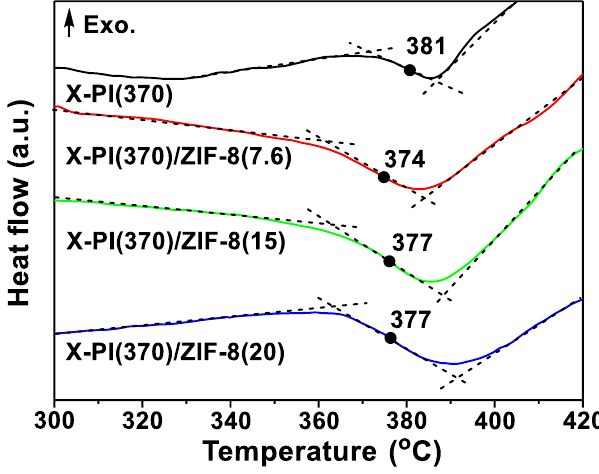
Figure 7. DSC thermograms of X-PI(370) and X-PI(370)/ZIF-8 MMMs. The numbers in the parentheses are the ZIF-8 loadings.